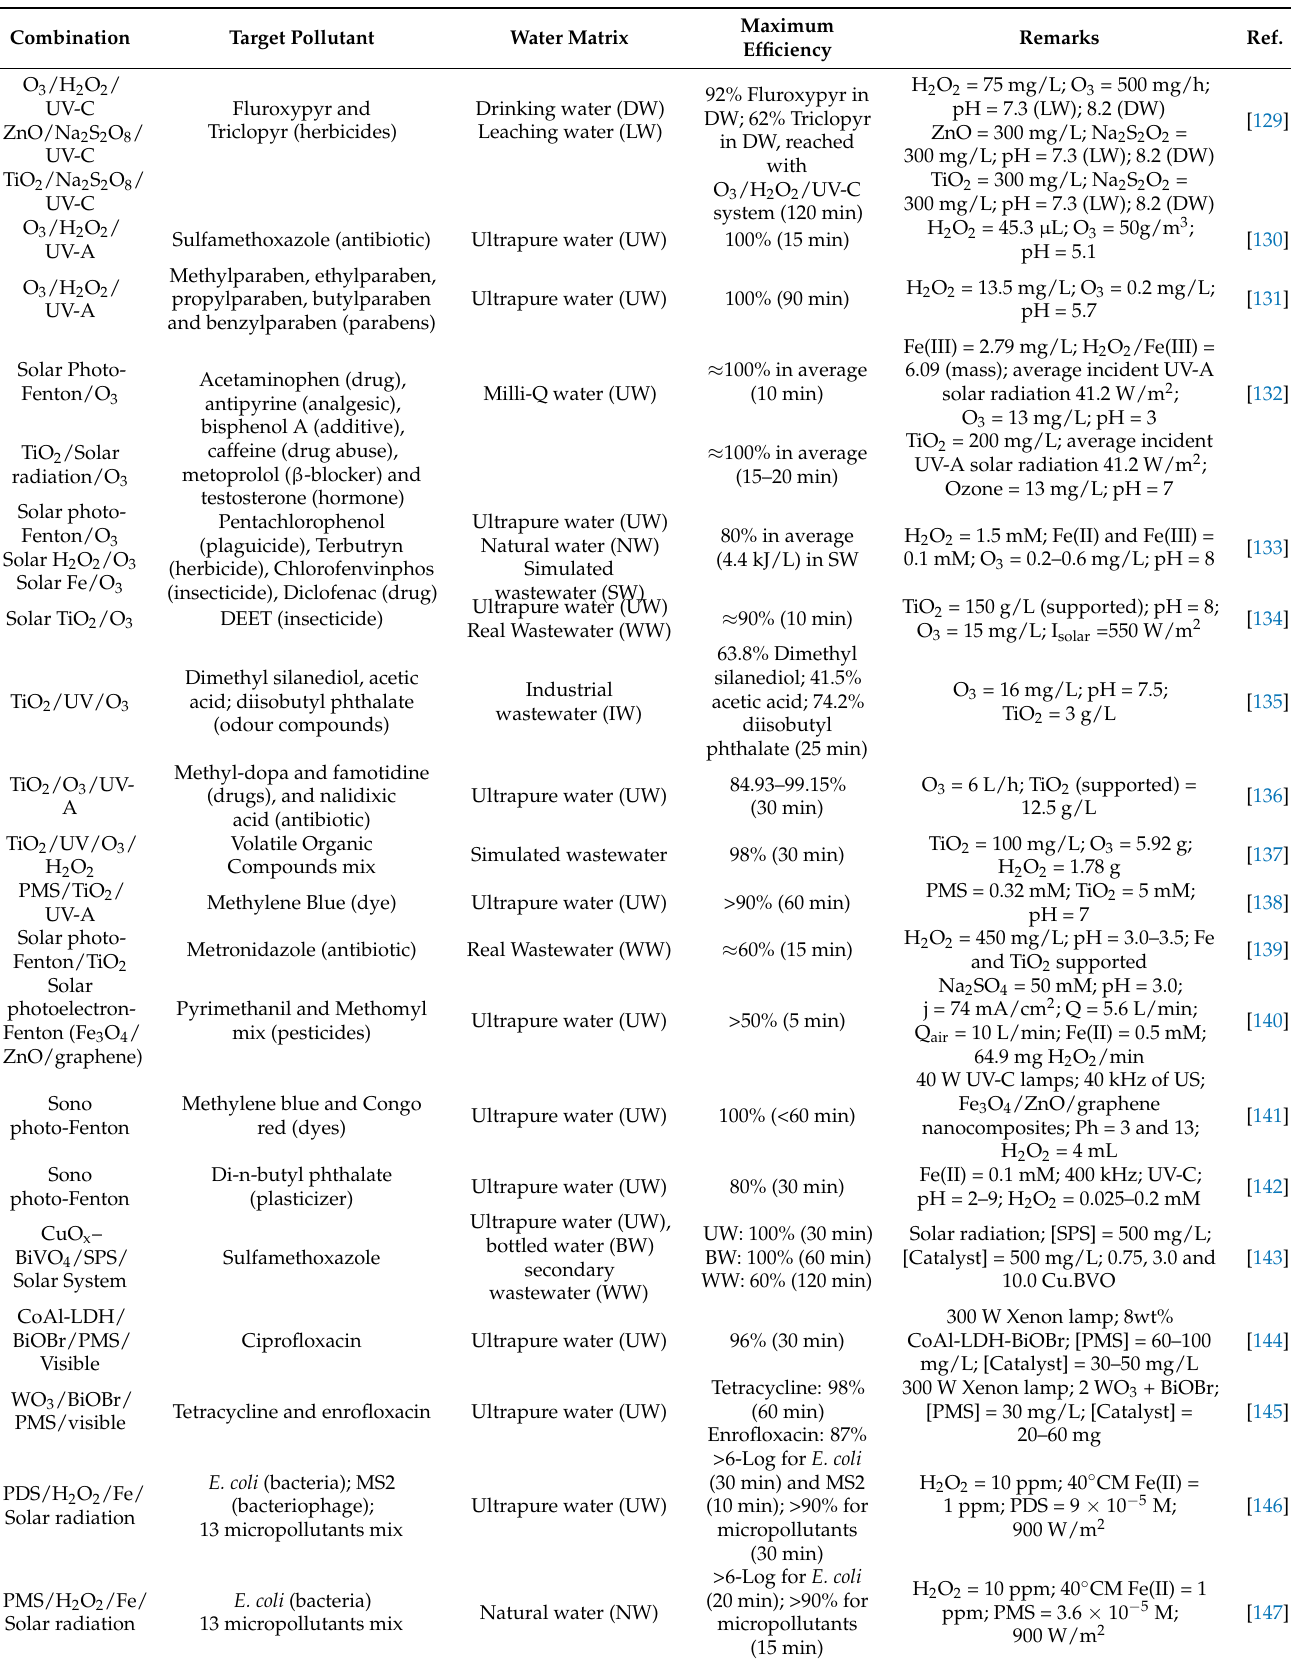
Table 10. Hybrid or single-step combination of photo-assisted advanced oxidation